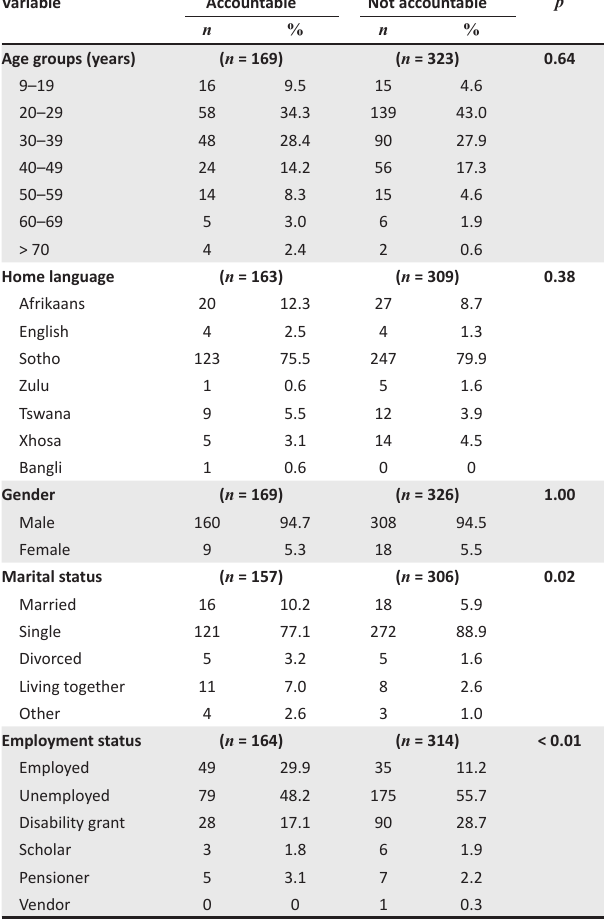
TABLE 2: Socio-demographic data of observati at the time of the offence. Variable